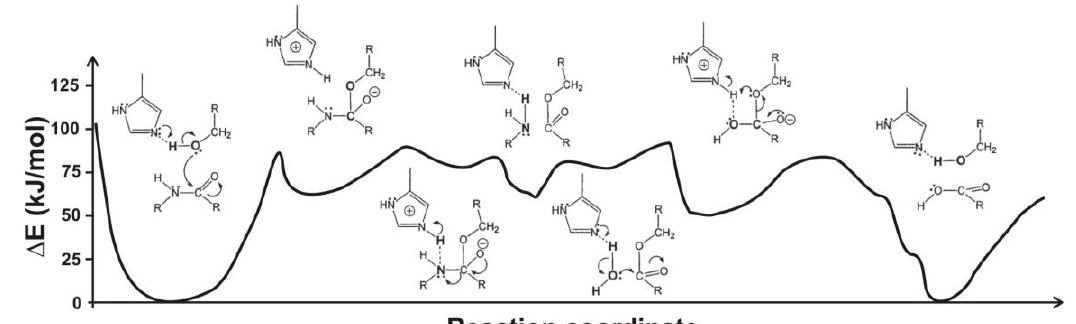
Figure 4. Reaction energy profile of the chymotrypsin-catalyzed cleavage of a model substrate (after Hudáky and Perczel [53]). Note that the tetrahedral intermediates as well as the acyl enzyme represent local